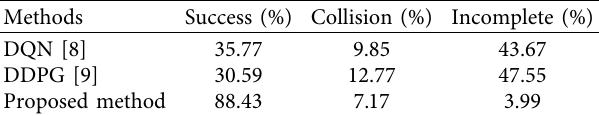
Table 3: Test results under random target point scenarios.